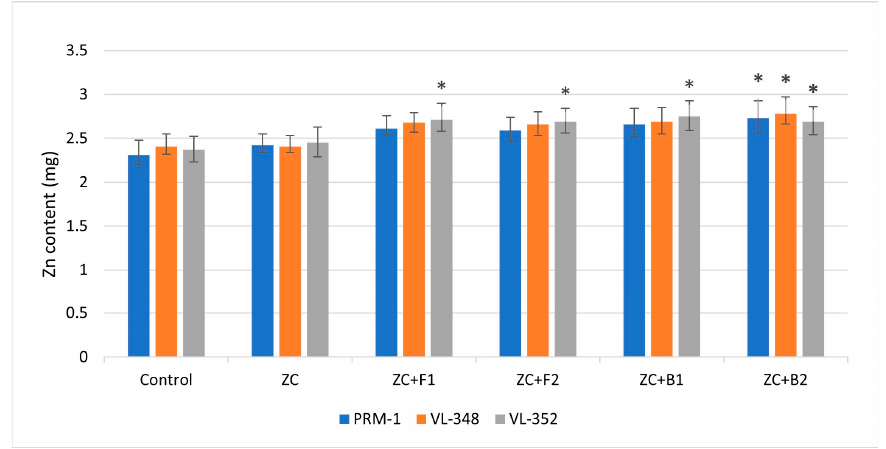
Figure 7. Endophyte inoculation influencing grain zinc contents. Error bars indicate the mean of triplicate experiments ± standard deviation. (ZC—Zinc carbonate; F1—EC1F-15; F2—EC1F-23; B1—EC3B-22; B2—EC3B-23.) * Indicates significate values at 5% probability.